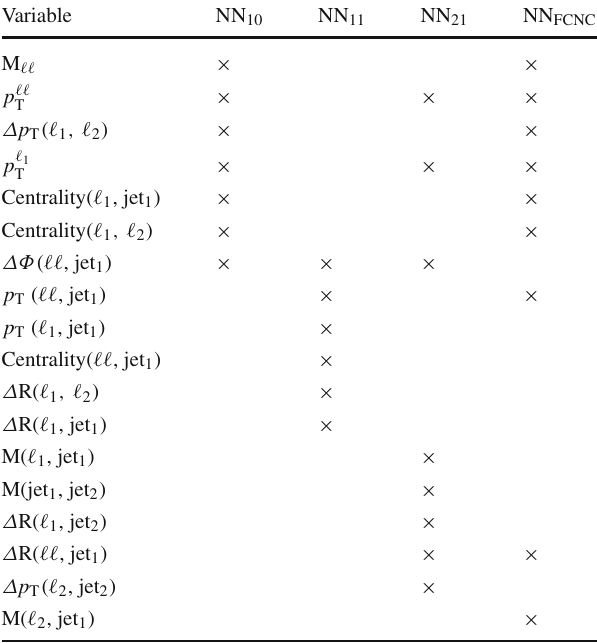
Table 4 Input variables for the NN used in the analysis in various bins of n -jets and m -tags. The symbols “ × ” indicate the input variables used in the four